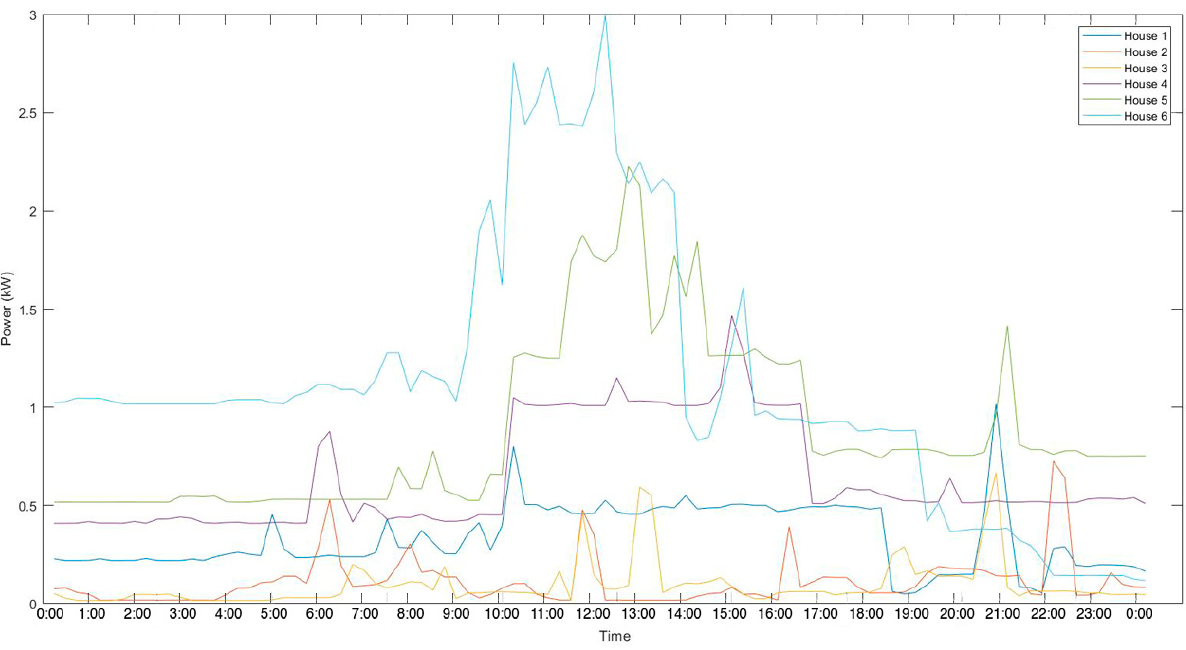
Figure 5. Electrical energy consumption in the houses.